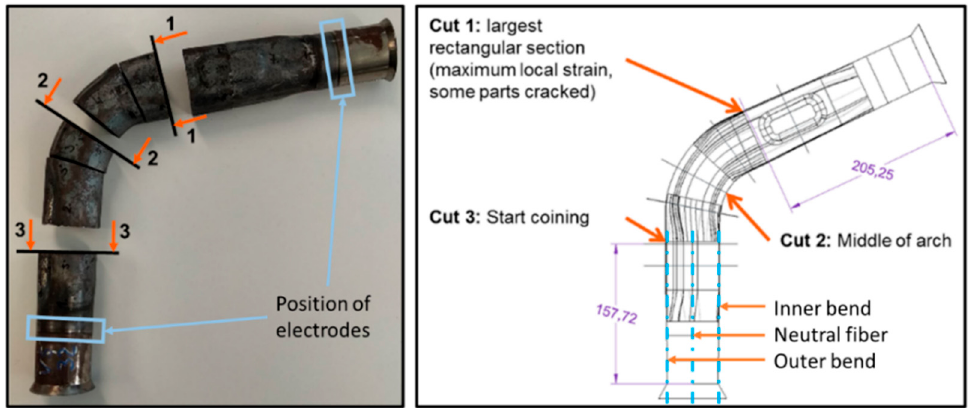
Figure 8. C omponent formed by HMGF and position of cuts. Figure 8. Component formed by HMGF and position of